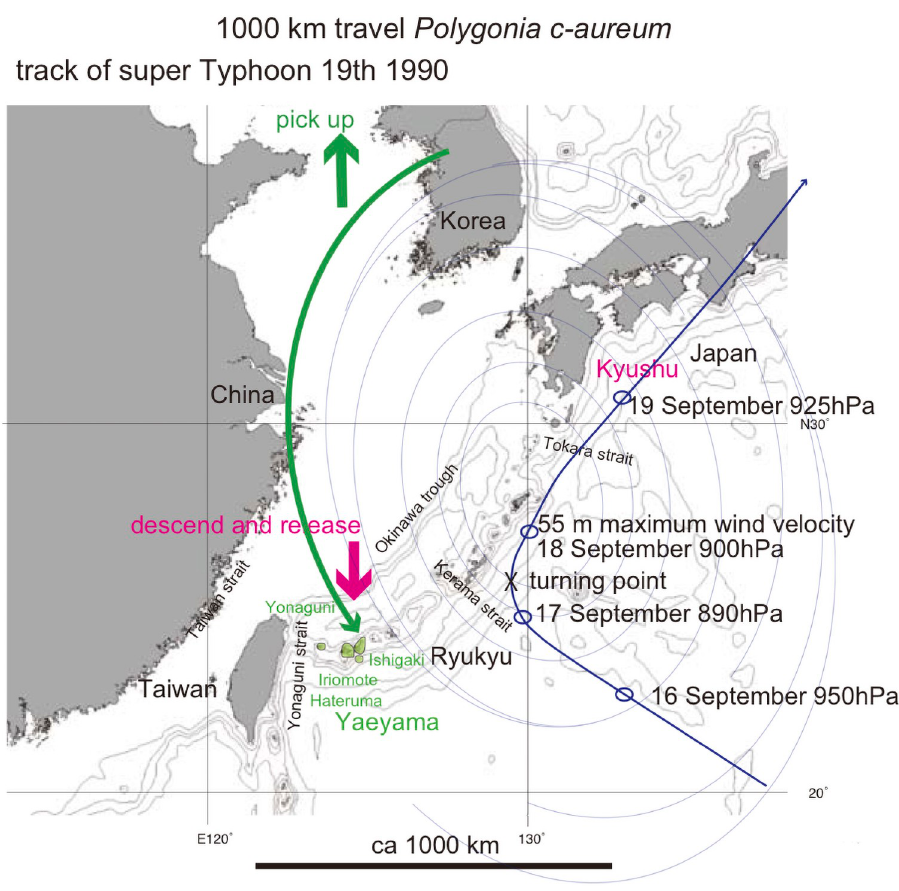
Fig 11. Track of super Typhoon 19, 1990 (blue fine curved path), and 1000 km inferred transport of Polygonia c- aureum by typhoon winds (green curved arrow). The bold short arrows schematically (not to scale) show where the typhoon winds picked up cicada (green) and where the same cicada were released (red). Base map from Vector Map (VMap) Level 0, National Geospatial-Intelligence